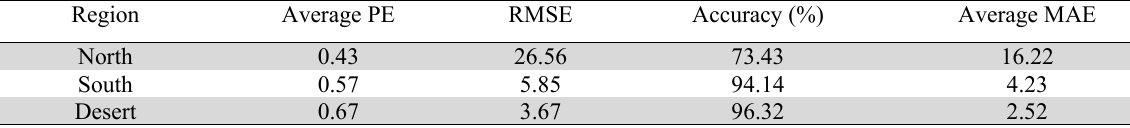
Table 7 Calculated Error Measures for north , south, desert